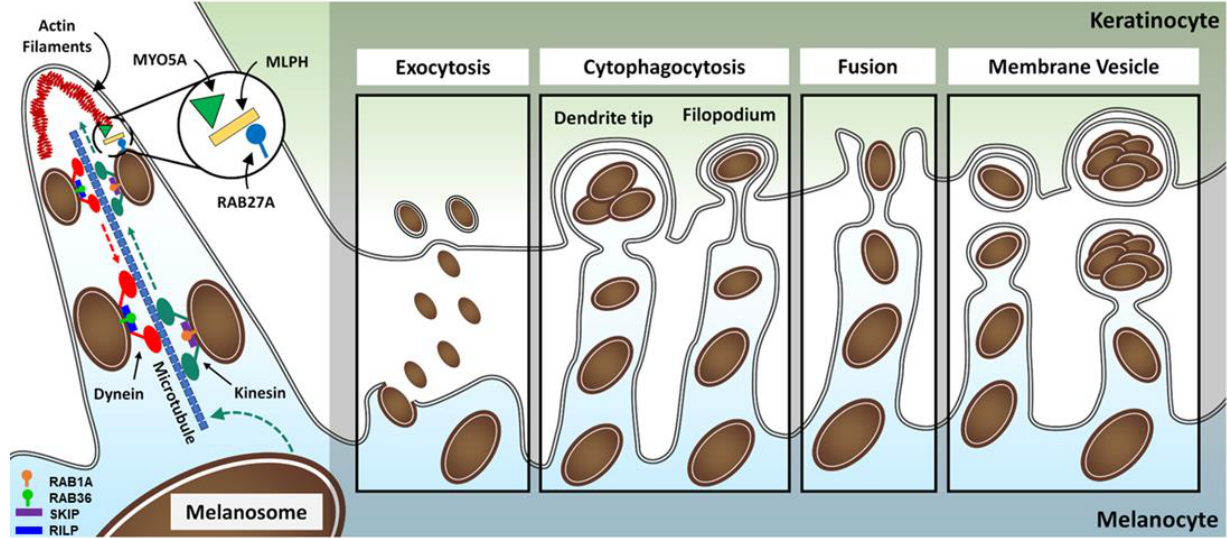
Figure 7. Mechanisms of melanosome transport and transfer. Melanosomes bind kinesin to move along microtubules from the perinuclear region to the periphery of melanocytes. This anterograde movement is regulated by RAB1A and its effector protein SKIP. At the dendrites, the movement of melanosomes in the rich network of actin filaments is regulated by the RAB27A–MLPH–MYO5A complex. Retrograde microtubule-dependent melanosome transport (dynein-dependent) is regulated by RAB36 and its effector protein RILP. Several models have been proposed regarding the transfer of melanin from melanocytes to surrounding keratinocytes; the most recent evidence points towards the exocytosis/endocytosis and membrane vesicle shedding models. MLPH: melanophilin; MYO5A: myosin VA; RAB1A: Ras-related protein RAB1A; RAB27A: Ras-related protein RAB27A; RAB36: Ras-related protein RAB36; RILP: Rab interacting lysosomal protein; SKIP: skeletal muscle and kidney enriched inositol